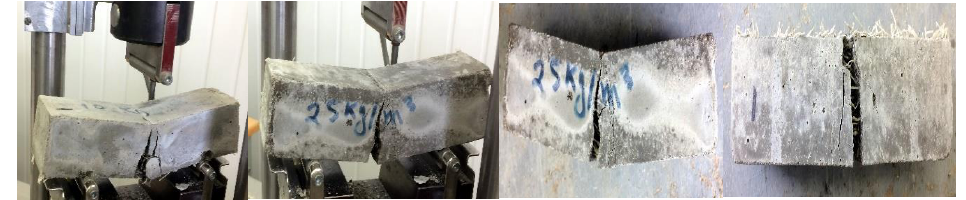
Figure 7. Concrete samples after final bending result.